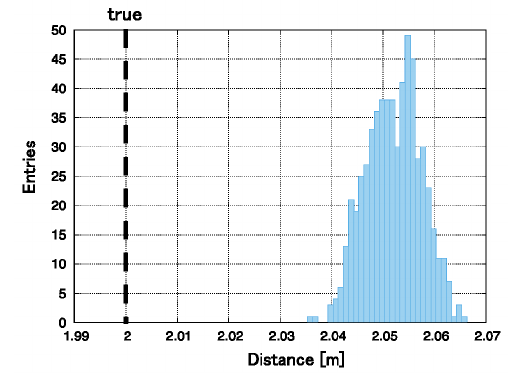
Figure 6. Ranging accuracy of RTK-GPS on the